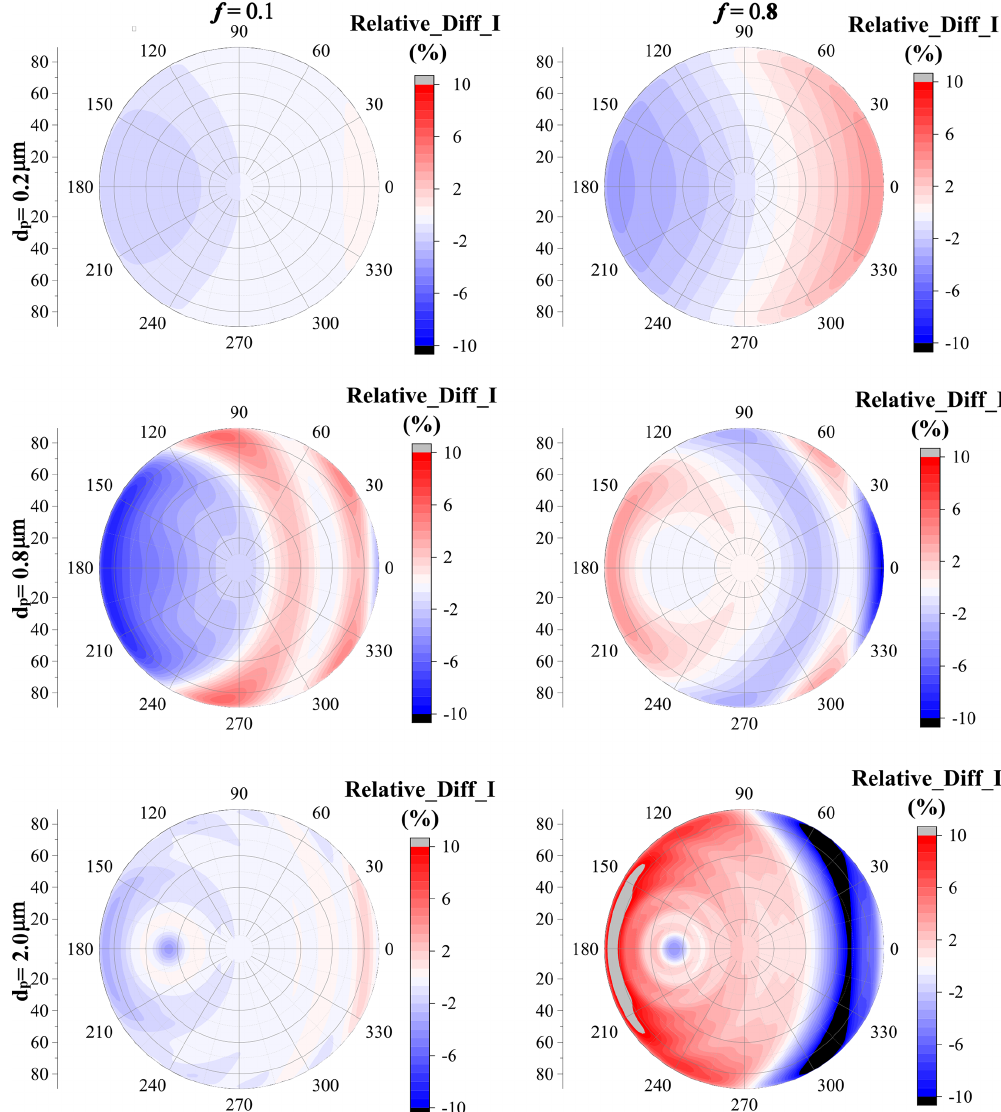
Figure 13. The relative difference of normalized radiance between dust with irregular shapes and best-fitted spheroids, where the aspect ratio is 2 : 1 and R =